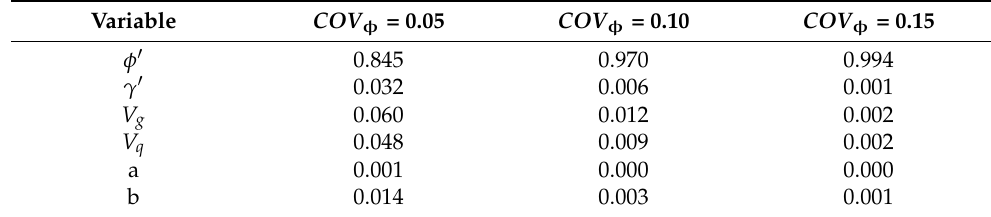
Table 6. First order Sobol indices of the SLS limit state function of shallow foundation in non- coherent